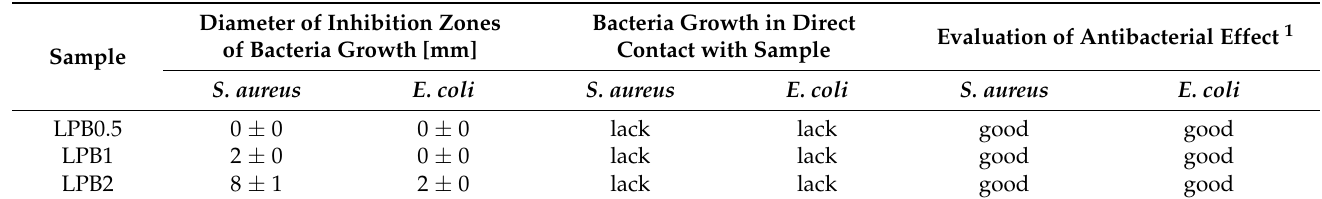
Sample Table 4. Assessment of antibacterial properties of the studied polymeric films containing berberine.